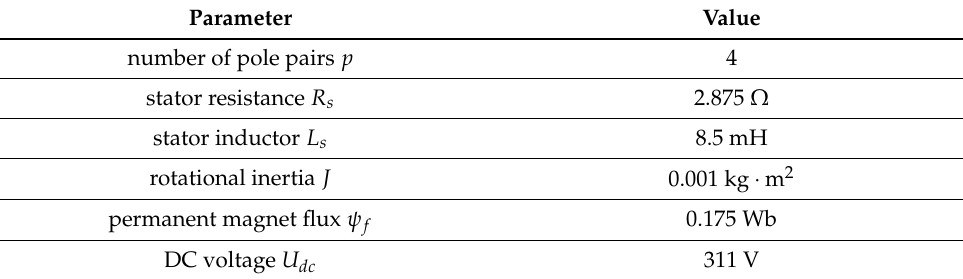
Table 1. Main parameters of